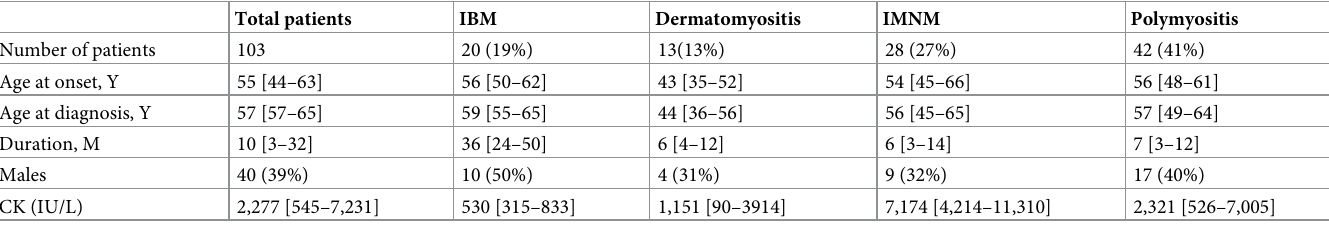
Table 1. Demographic characteristics of 103 patients with inflammatory